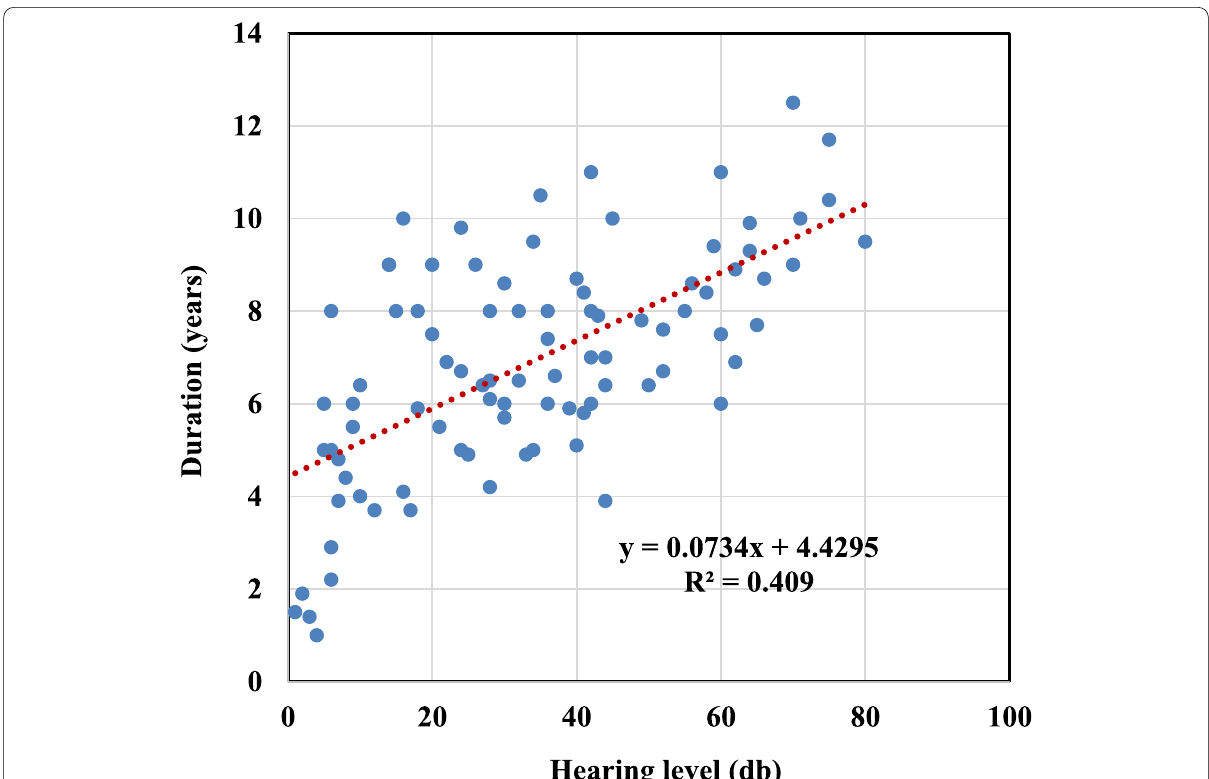
Fig. 1 Correlation coefficient (r) and regression line between duration of systemic lupus erythematosus (SLE) and sensorineural hearing loss (SNHL). There is a strong positive association ( r 0.6395, p < =